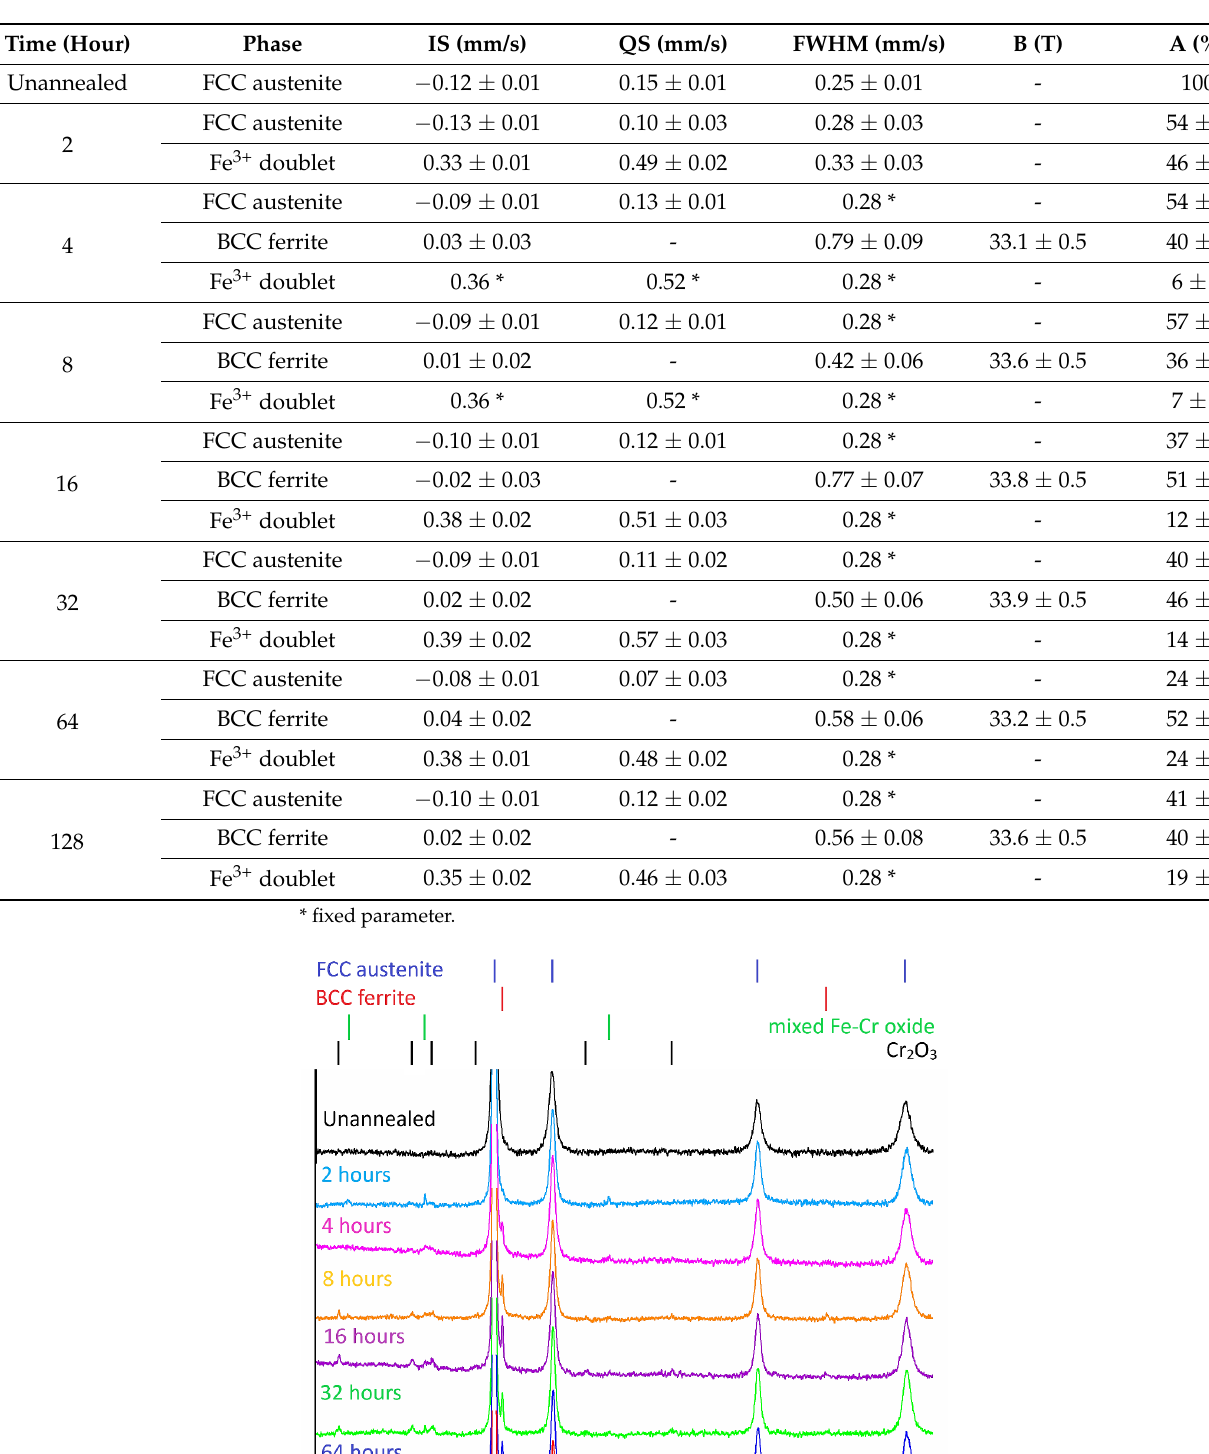
Table 3. Conversion electron Mössbauer spectroscopy parameters of all samples (IS, isomer shift; QS,